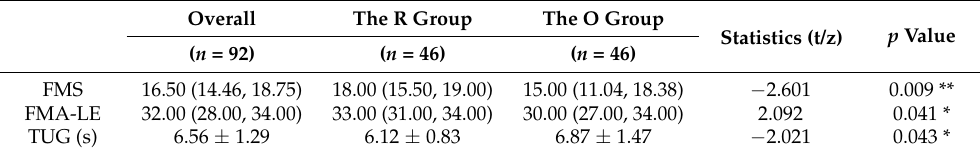
Table 2. Lower extremity motor capacity of the older women in the O and R groups. Overall The R Group The O Group